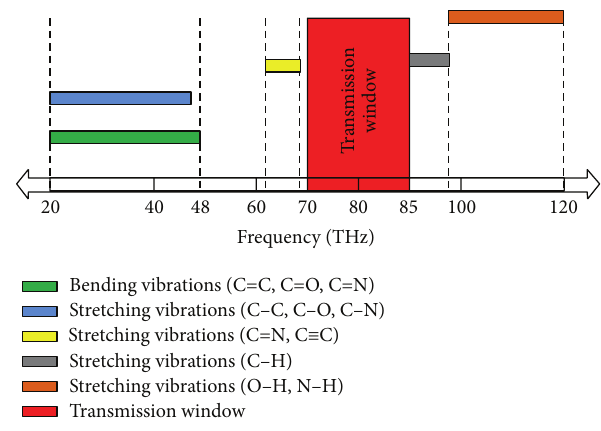
Figure 6: IR spectroscopy correlation table with vibration and transmission